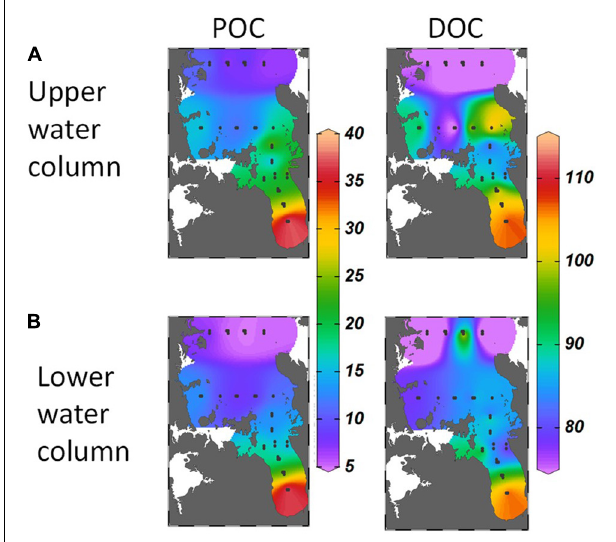
FIGURE 6 | POC, and DOC (mmol m − 3 ) in (A) upper and (B) lower water columns averaged across seasons in 2012-13, over the Hauraki Gulf and Firth at sites indicated by